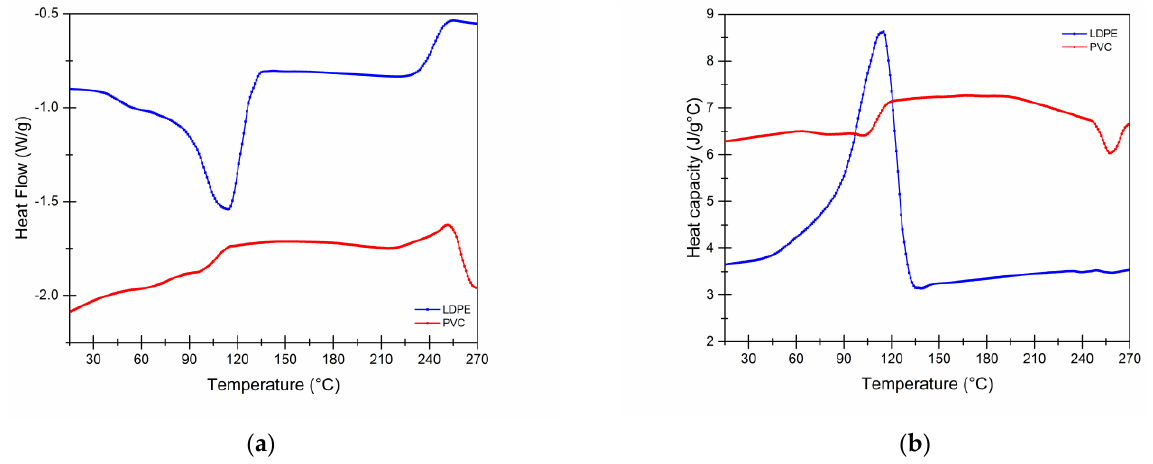
Figure 6. ( a ) Representative heat flow thermogram (W/g). ( b ) Specific heat (J/g °C) of PVC and LDPE films.